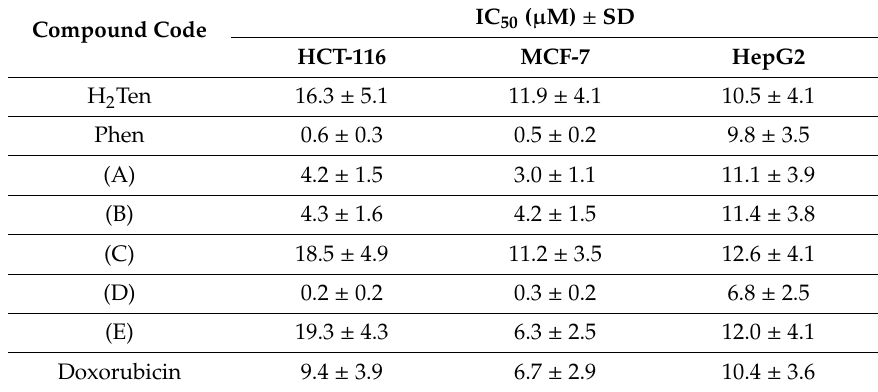
Figure 7. Dose dependent cytotoxic activities of H 2 Ten, Phen and their metal complexes against HepG2 cancer cells according to the MTT assay. Where: 3.12, 6.25, 12.5, and 25.0 µ M are the concentrations, diluted in DMSO, used for the MTT assay. Table 6. IC 50 of the tested compounds against the three cancer cell lines according to the MTT